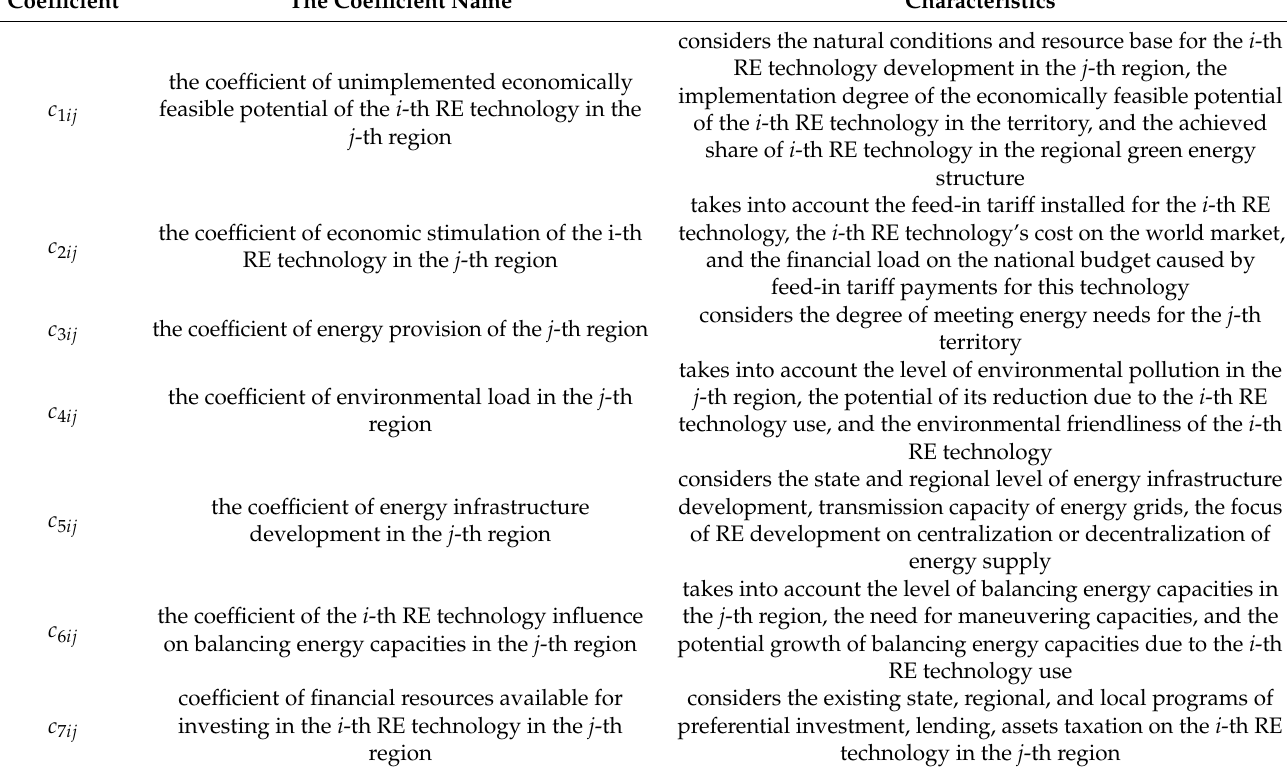
Table 1. The characteristics of the coefficients c fij (developed by the